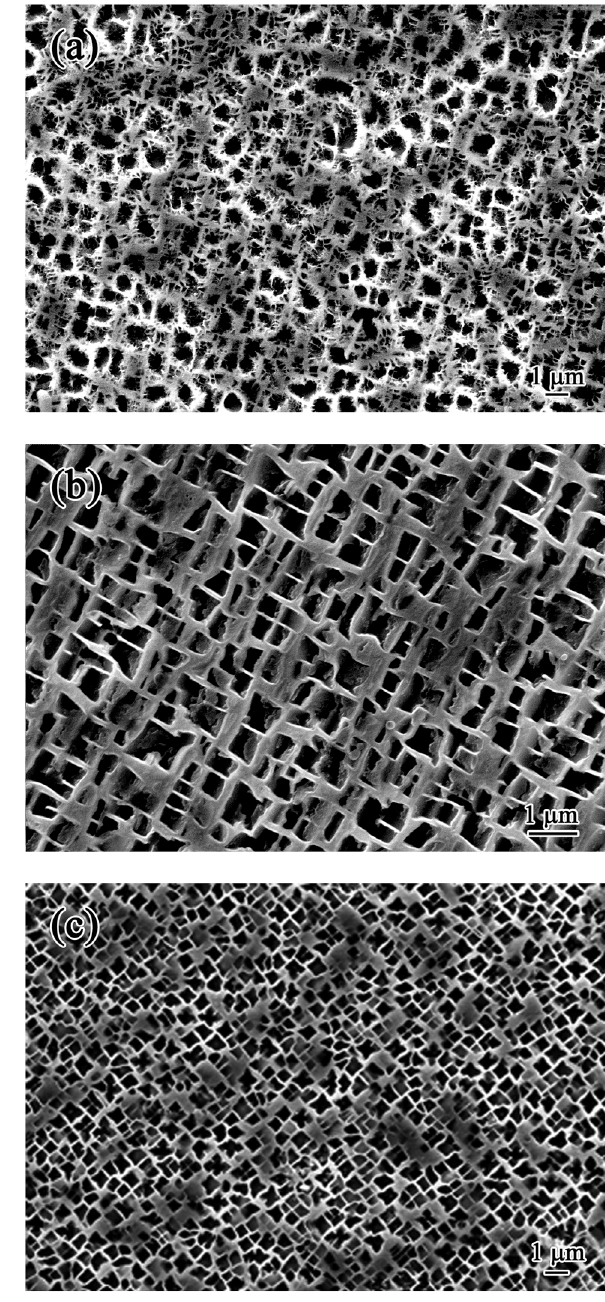
Figure 2: The γ ′ morphology under various HIP conditions. (a) 1,190°C/